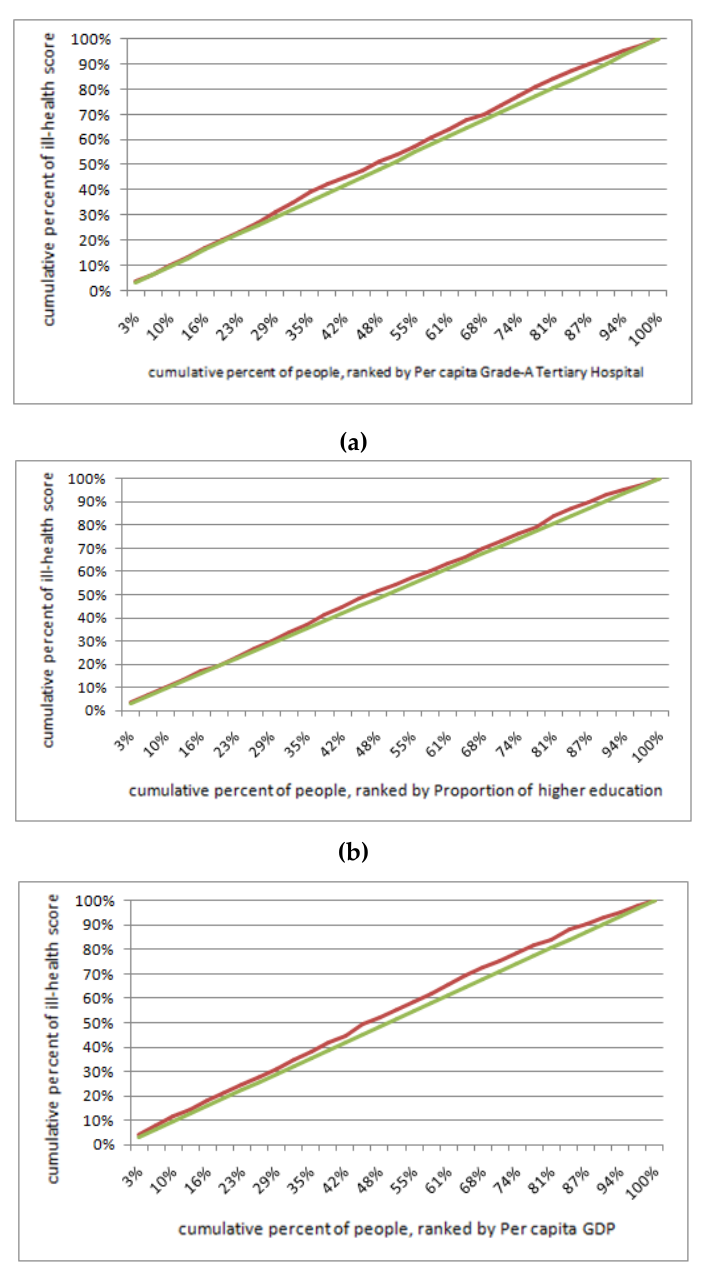
Figure 4. Ill-health concentration curve (red curve) of elderly health by socio-economic status (SES) difference at the provincial-level in China. (a) Medical resources-related elderly health inequality, CI = –0.083; (b) education-related elderly health inequality, CI = –0.093; (c) economic-related elderly health inequality, CI = –0.109.